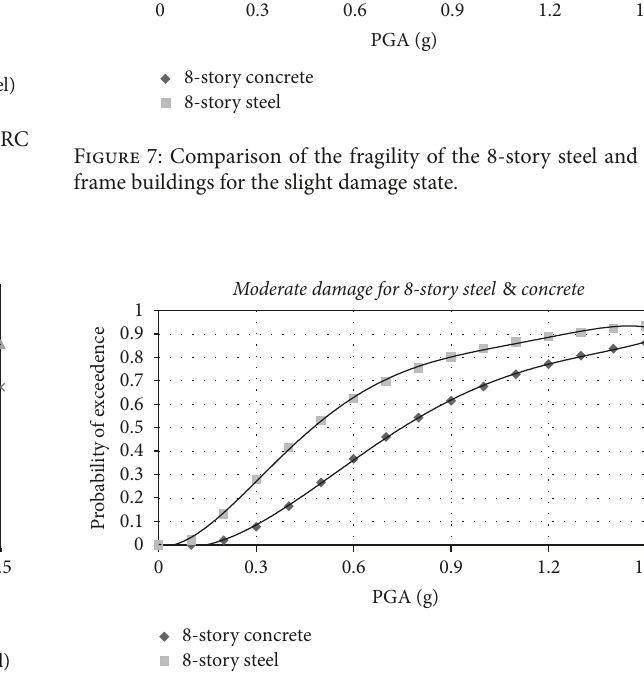
Figure 5: Comparison of the fragility of the 12-story steel and RC frame buildings for the extensive damage state.